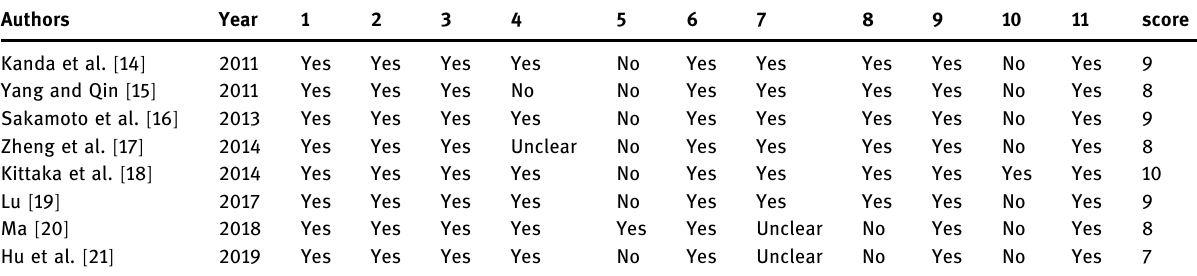
Table 2: Quality evaluation of the included studies